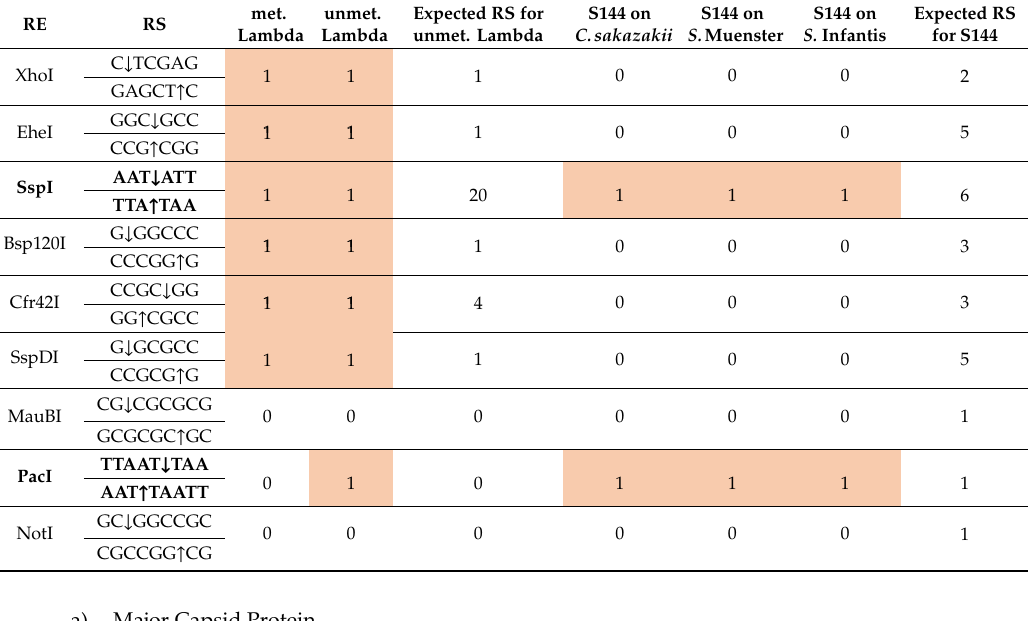
Table A5. Summary of the restriction analysis of phage S144 DNA, propagated on C. sakazakii CS1, S. Infantis S15 and S. Muenster S394. DNA from phage Lambda (methylated and unmethylated) have been used as controls. The restriction site for each of the nine used enzymes is specified and in each cell, it is indicated if the DNA was cut (1, in orange) or not (0, in white). SspI and PacI, the only two enzymes able to cut S144 DNA, are in bold. RE, restriction enzymes; RS, restriction sites, met., methylated; unmet.,